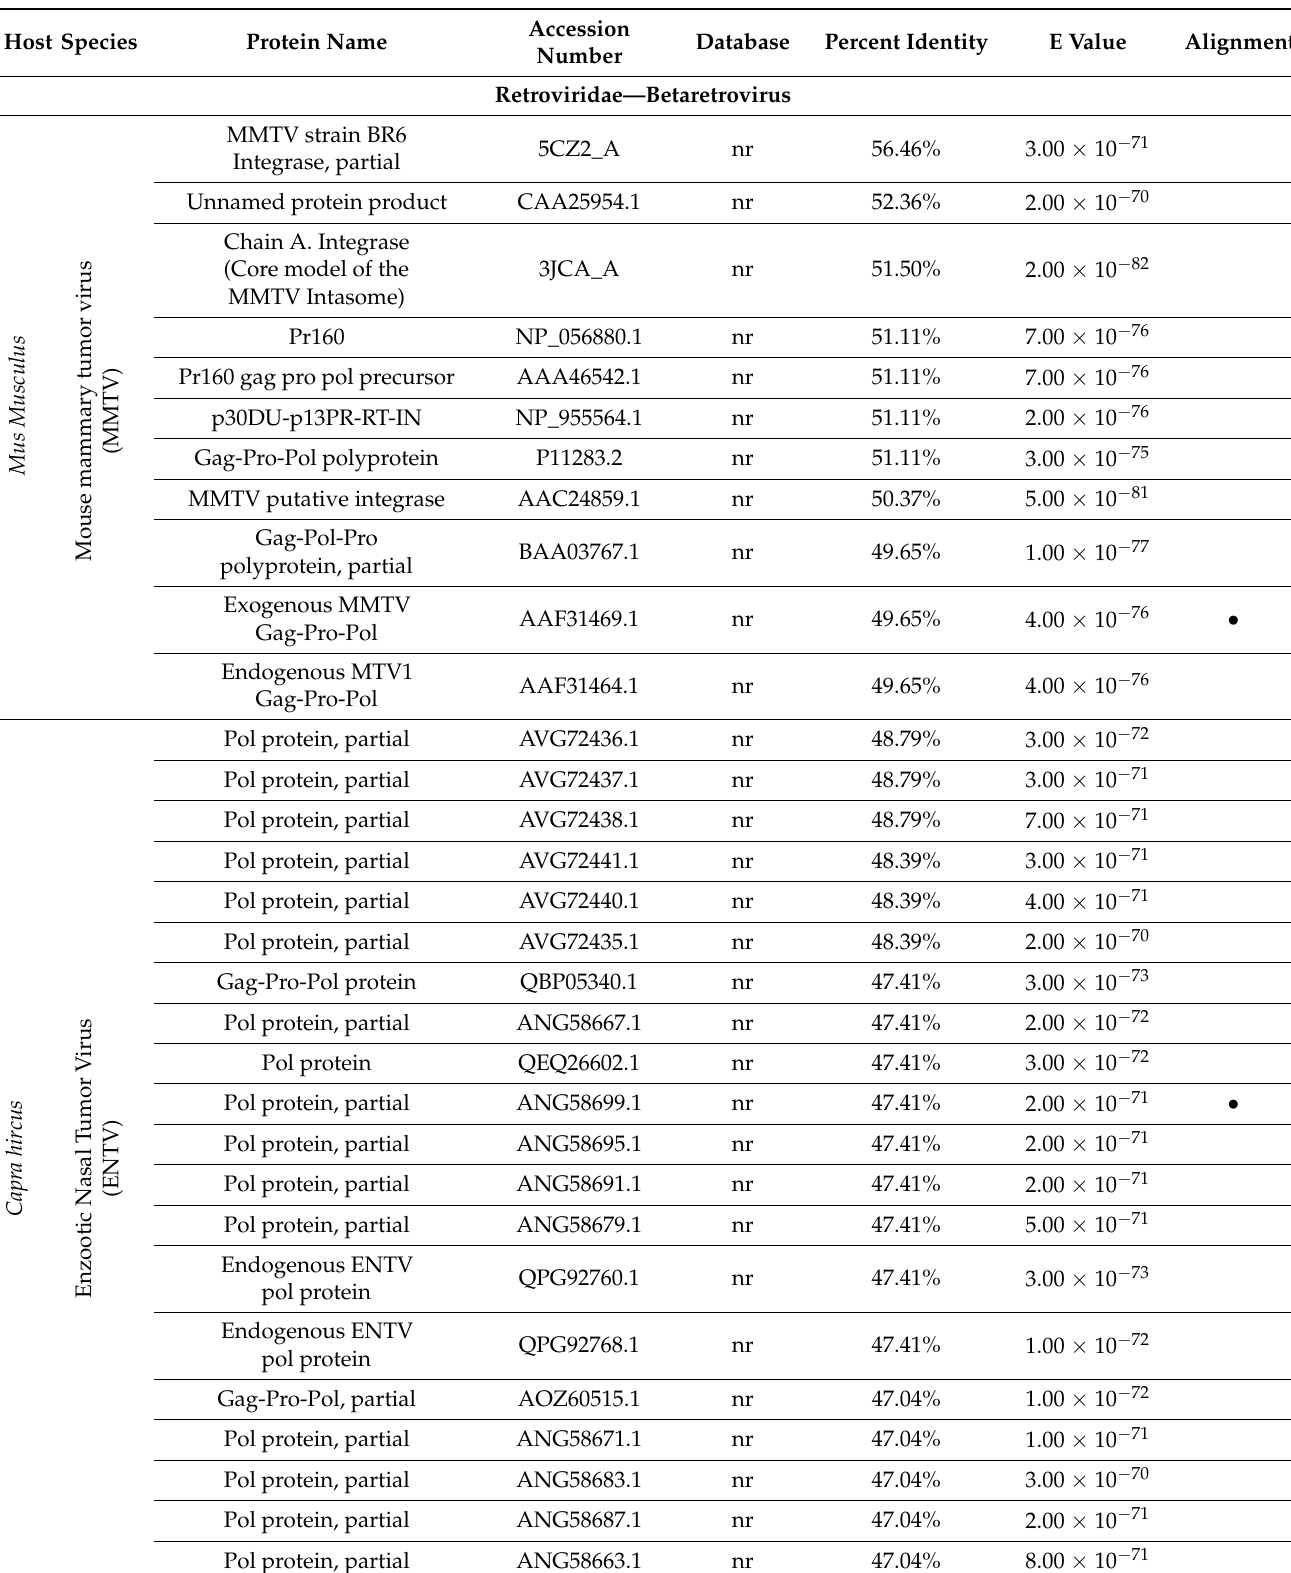
Table A1. Exogenous viruses with similarity to ERVK integrase based on BLASTp